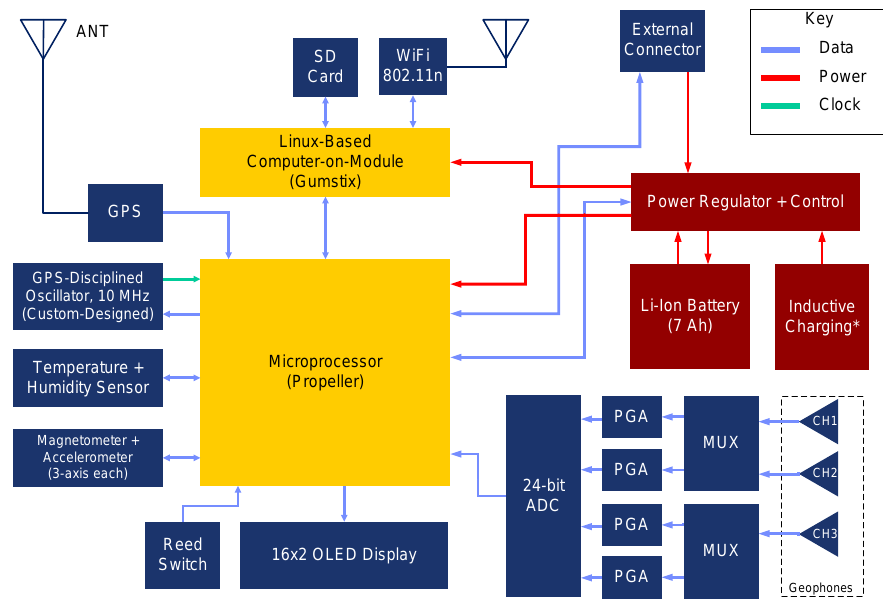
Figure 2. Block diagram of the geoPebble board, including all the relevant circuits, such as micropro- cessor, GPS, seismic digitizer, WiFi, etc.